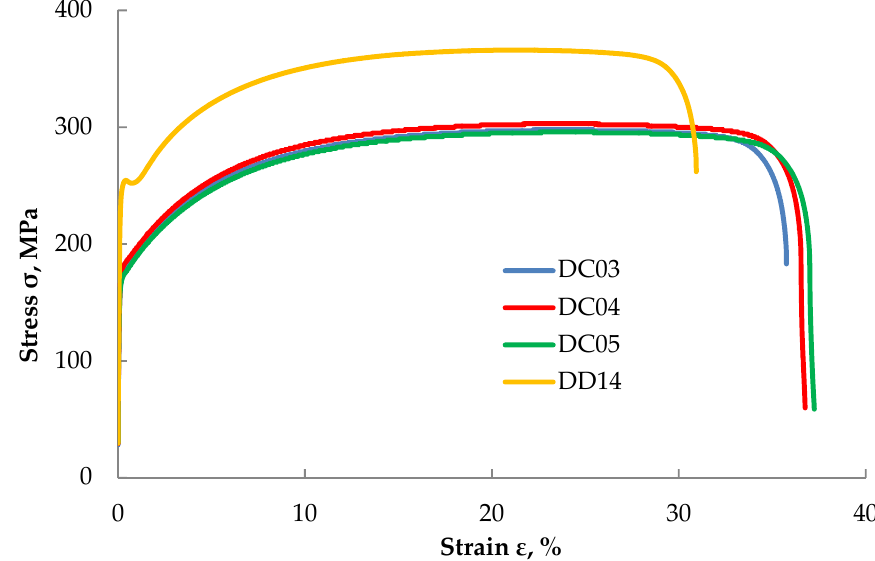
Figure 4. Tensile stress-strain relationship for the investigated steel sheets.